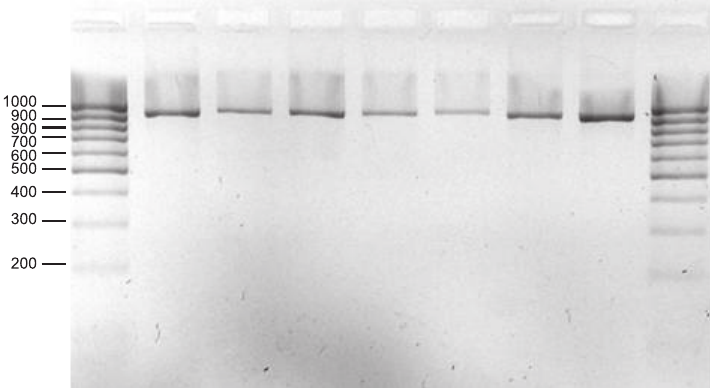
Fig. 2. Electrophoretic separation of amplification products of perch, Perca fluviatilis , using primers sequences; M = molecular weight DNA: pUC19 x Mspl (Serva Electrophoresis); Lanes: 1–3 CR1, 4–6